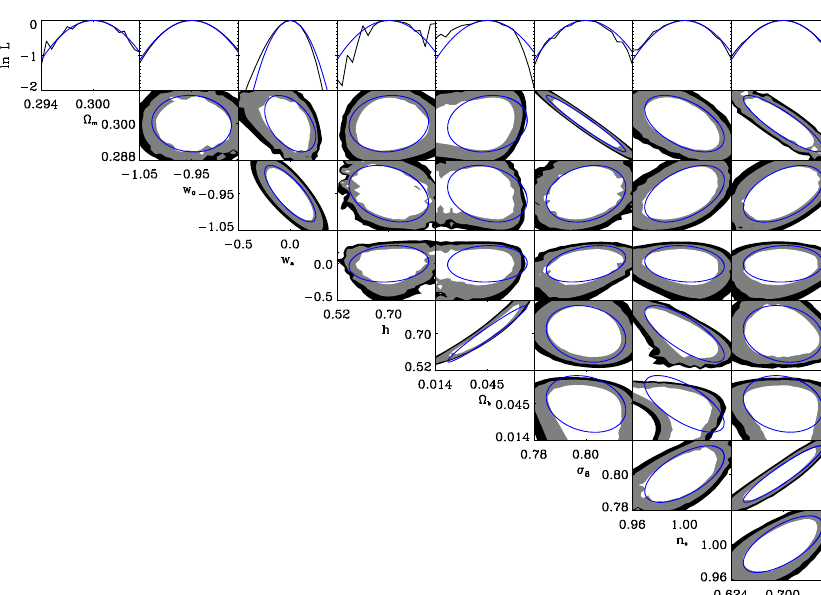
Fig.62 Projectedcosmological8-parameterspacefora15,000squaredegrees,medianredshiftof z = 0 . 8, 10 bin tomographic cosmic shear survey. Specifications are based on Euclid Yellow book (Laureijs et al. 2009)asthisfigureisrepresentativeofamethod,ratherthanonforecast analysis; thediscussion isstill valid with more updated (Laureijs et al. 2011) Euclid specifications. The upper panel shows the 1D parameter constraints using analytic marginalization (black) and the Gaussian approximation (Fisher matrix, blue, dark grey). The other panels show the 2D parameter constraints. Grey contours are 1- 2- and 3- σ levels using analytic marginalization over the extra parameters, solid blue ellipses are the 1- σ contours using the Fisher-matrix approximation to the projected likelihood surface, solid red ellipses are the 1- σ fully marginalized. Image reproduced by permission from Taylor and Kitching